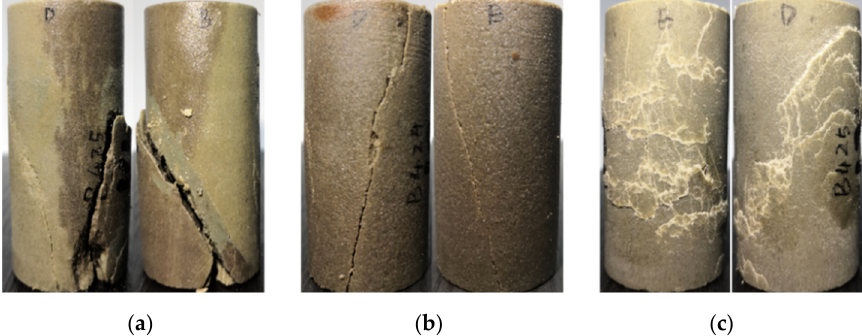
Figure 1. Core fracture morphology. ( a ) Single shear fractures. ( b ) Split fractures. ( c ) Complex fractures.